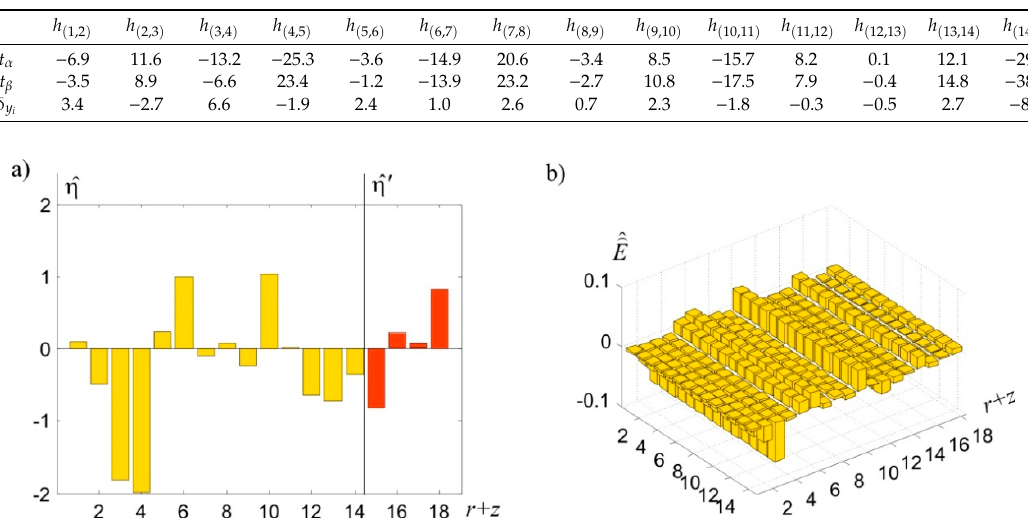
Figure 9. The courses of norms values in the iterative process: ( a ) random displacement ( b ) surface noise The TLSC estimators of deterministic displacements for both versions of signals’ standard deviations vary from each other. This is shown by the (